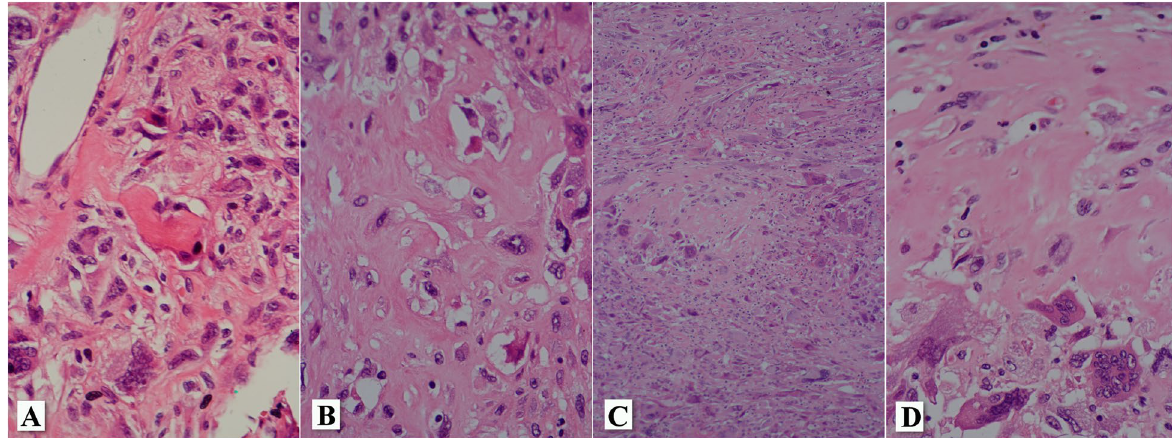
Fig. 3 Equivocal areas of osteoid formation that may yield differential diagnosis with collagenous stroma (HE – A , 400x; B , 400x, C , 40x; D , 400x)